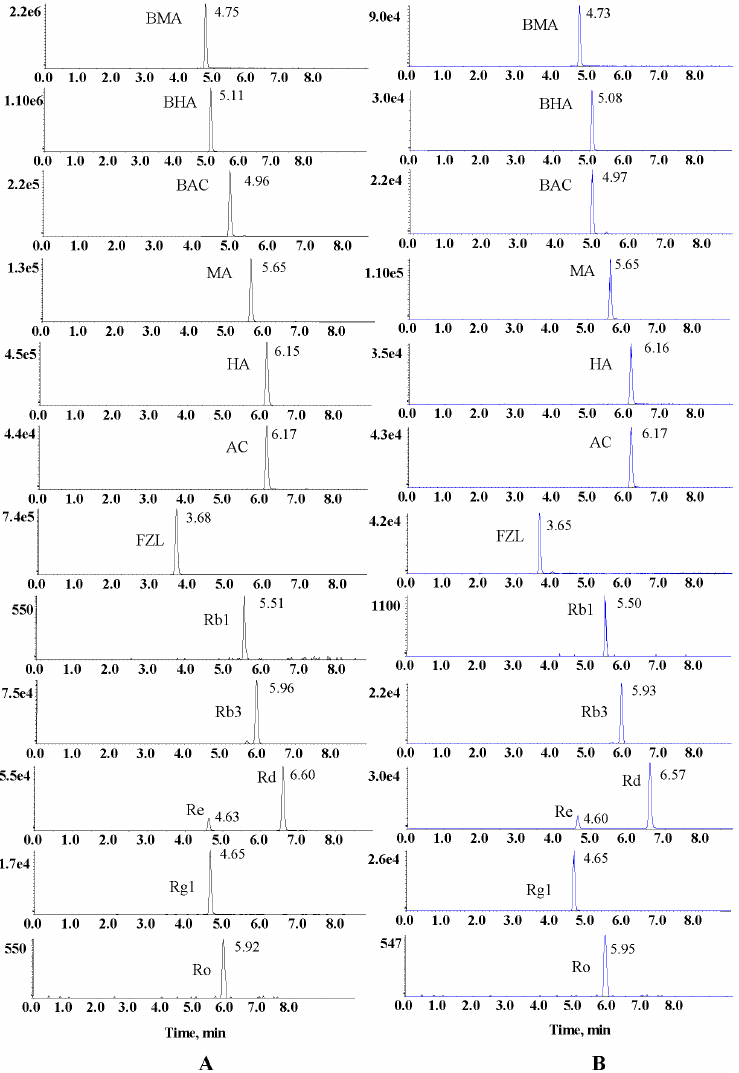
Figure 3. The multiple reaction monitoring (MRM) chromatograms of 13 analytes by UFLC-QQQ-MS/MS. ( A ) 13 analytes in sample solution; ( B ) 13 analytes in reference solution.